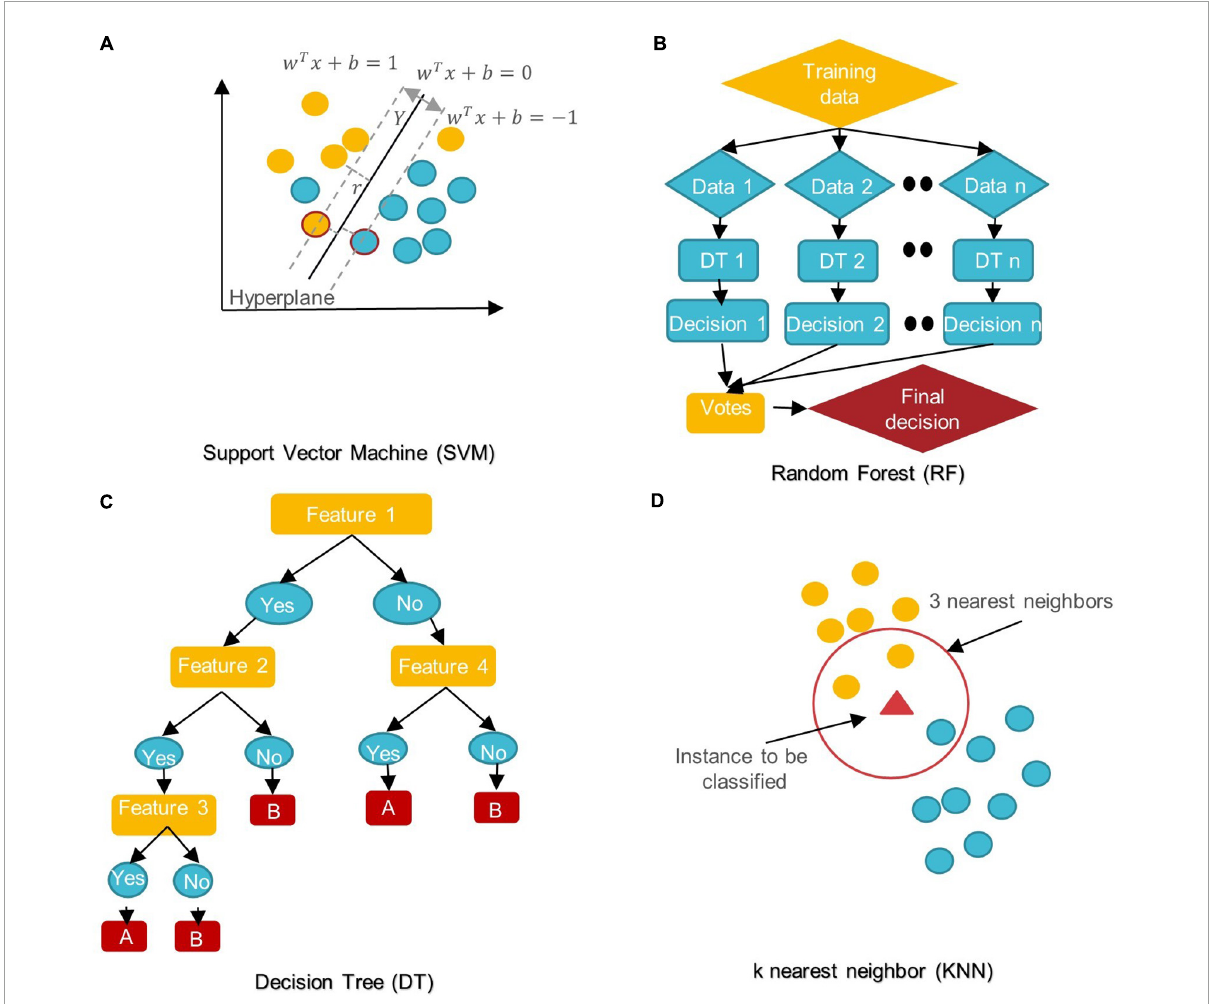
FIGURE6 Schemes of conventional ML algorithms commonly used in MRI-based studies to diagnose ASD (A) SVM: support vector machine; (B) RF: random forest; (C) DT: decision tree; (D) KNN: k nearest